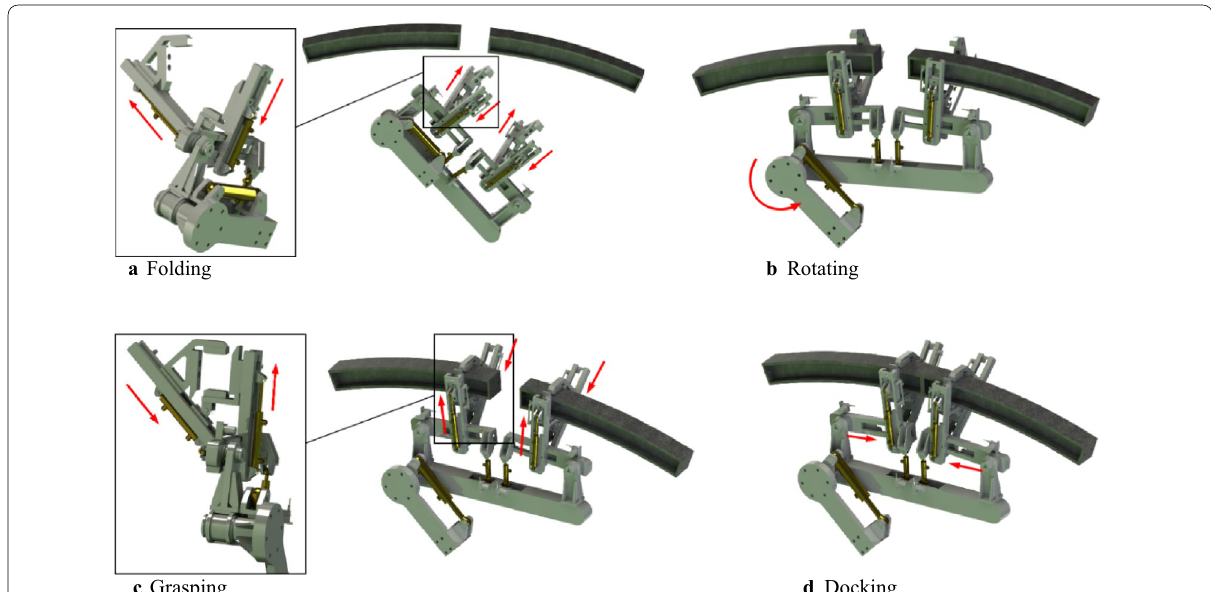
Figure 10 Working process of steel arch splicing